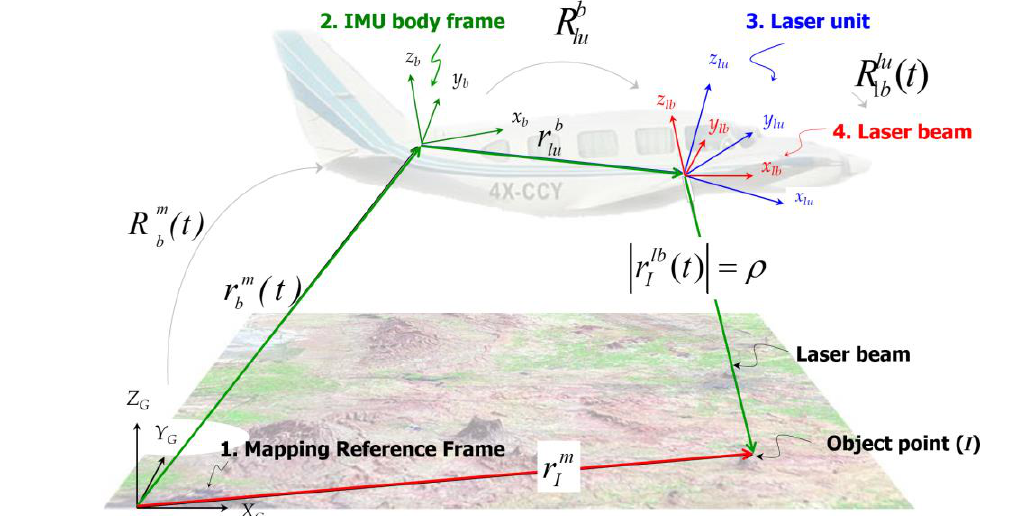
Figure 1: The LiDAR System Coordinate Frames and Associated